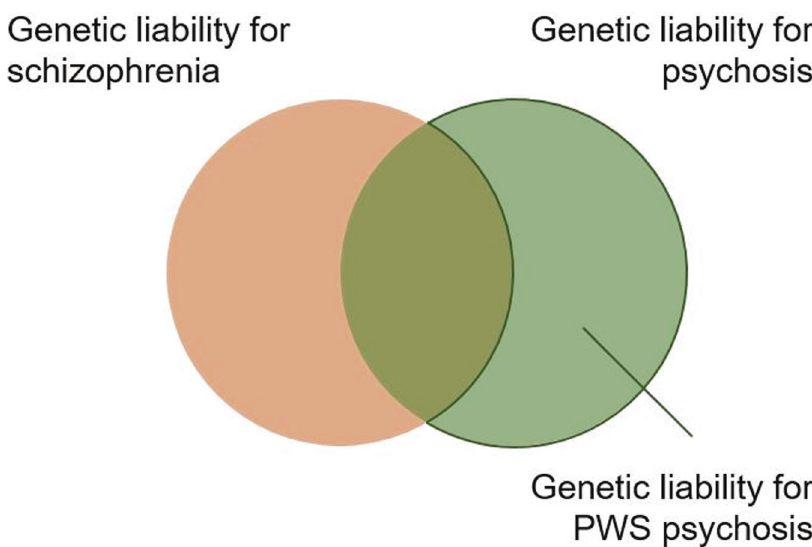
Fig. 6 Model of genetic liability for psychosis in individuals with PWS. Gene set analysis of differentially expressed genes and differentially used isoforms in whole neonatal mouse brain showed enrichment of genes relevant to psychotic experiences, but not schizophrenia. Although schizophrenia and psychotic experiences have a shared genetic liability, they are ultimately distinct psychiatric conditions phenotypically and genetically. We propose that the genetic liability for psychosis in PWS is distinct from that of